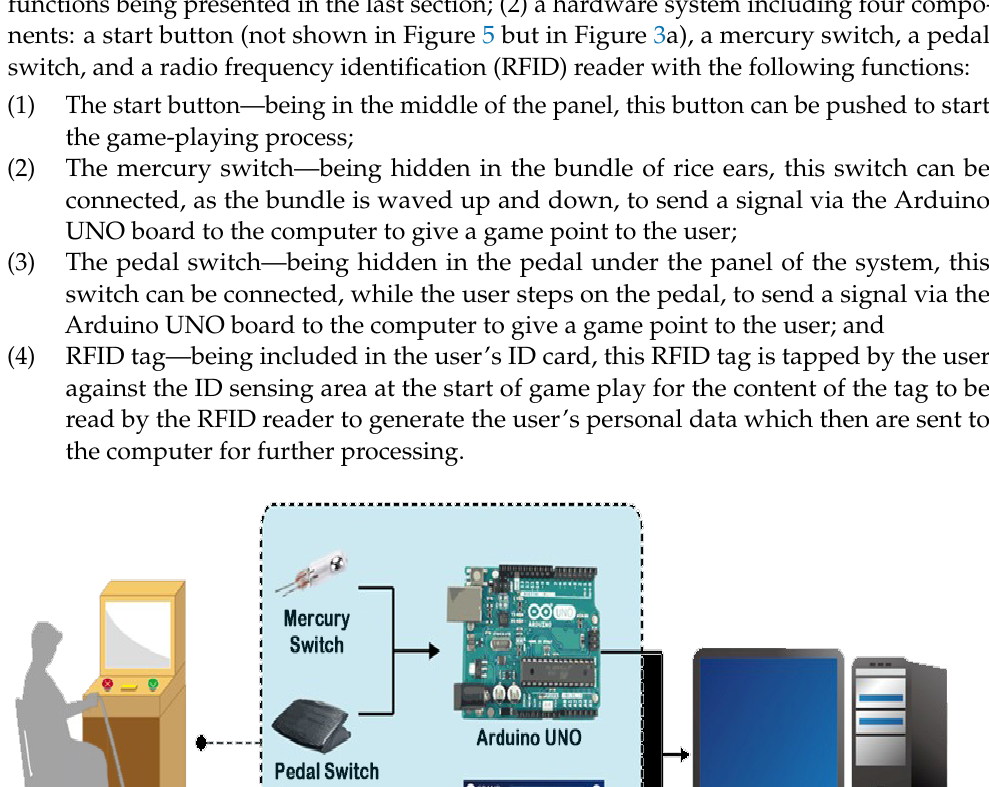
Table 4. A graphic illustration of an example of running the game playing process of the algorithm on the proposed system (from the viewpoint of the system using graphic pictures).